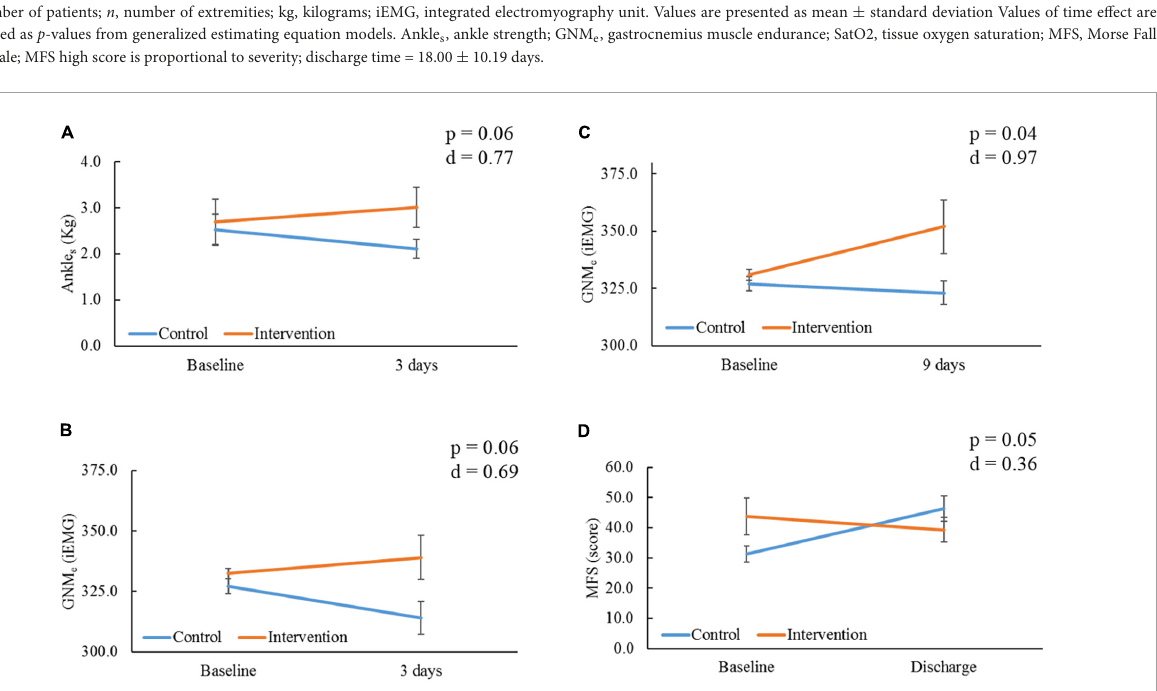
E-Stim therapy during the established study period (9